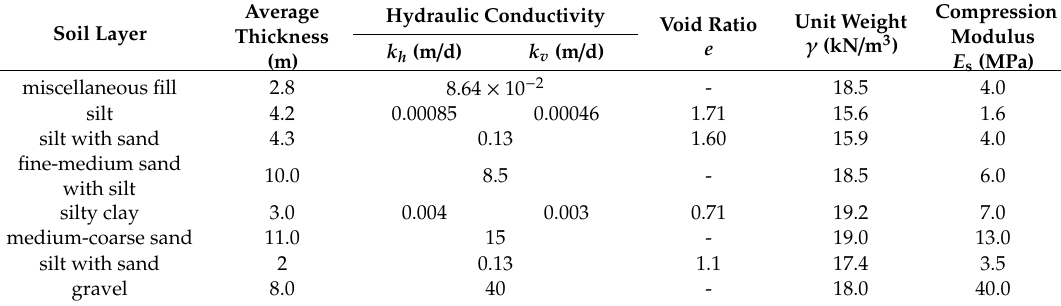
Table 1. Physico-mechanical properties of soil at the